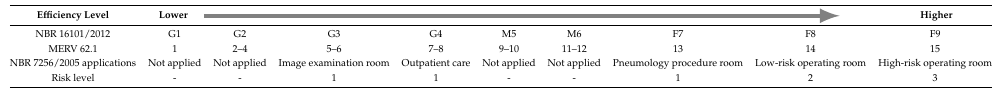
Table 2. Comparative view of filters according to ASHRAE 62.1 and ABNT/NBR 16101/2012 standards. Source: prepared by the